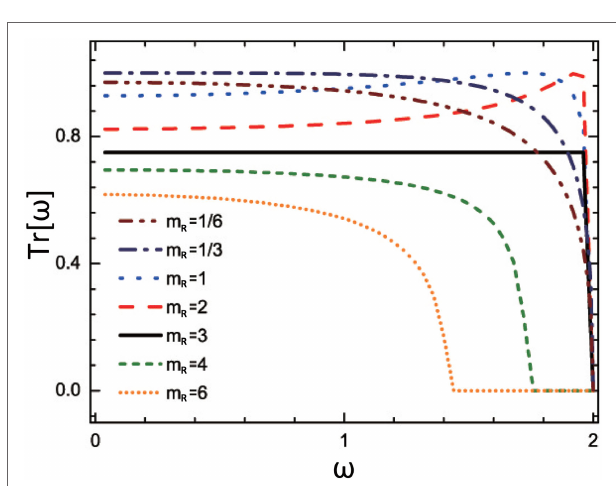
FIGURE 4 | Transmission coefficient Tr [ ω ] as a function of frequency ω for different mass ratios m R / k 12 m at k 12 m , adapted with permission from the copyright holder (American Physical Society), Zhang et al. (2011). Here, k L = 1.0, k R = 3.0, k 12 = 1.5, and m L =